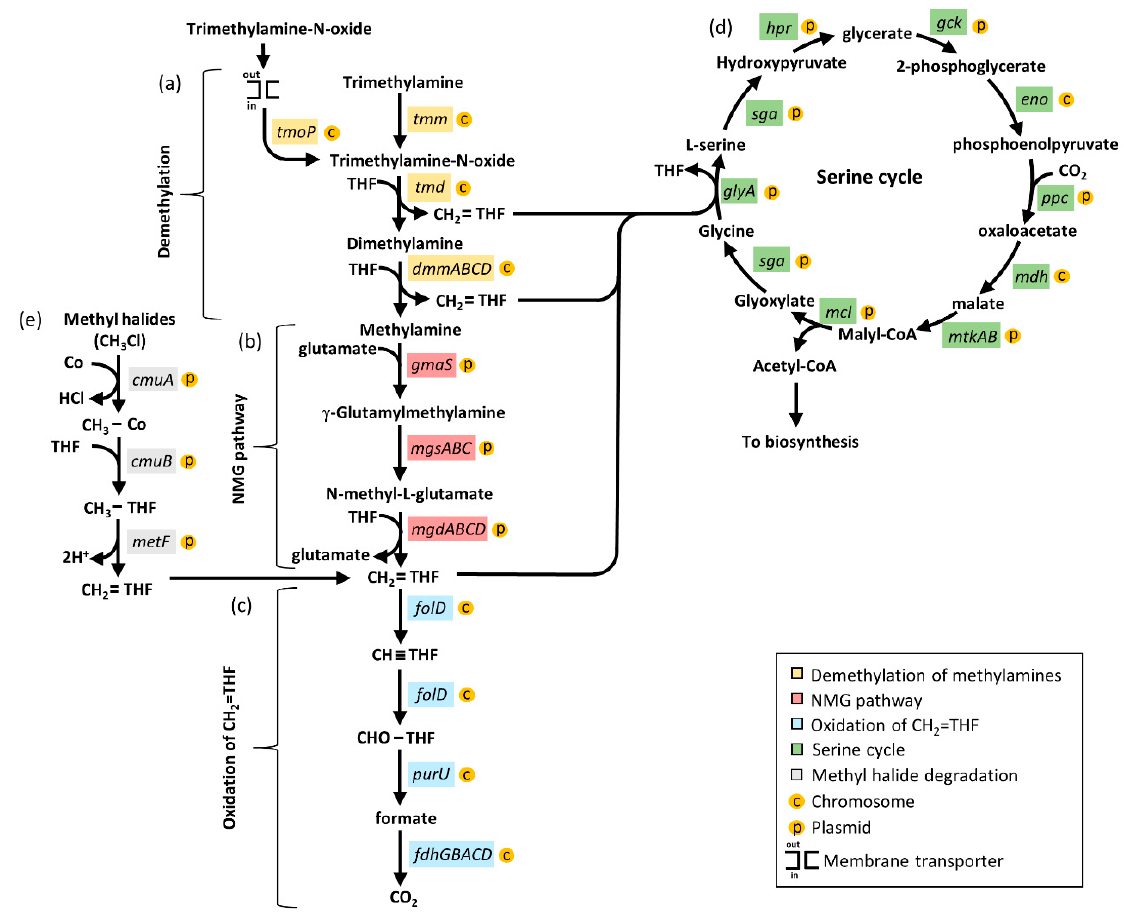
Figure 6. Methylotrophic metabolism in the Aminobacter genus. Genes are colored according to the metabolic pathway (see key). ( a ) Demethylation of methylamines: tmm , trimethylamine monooxygenase; tmd , trimethylamine-N-oxide demethylase; tmoP , trimethylamine-N-oxide permease; dmmDABC , subunits of the putative dimethylamine monooxygenase. ( b ) NMG pathway: gmaS glutamate-methylamine ligase; mgsABC , N-methylglutamate synthase subunits; mgdABCD , N-methylglutamate dehydrogenase subunits. ( c ) CH 2 =THF oxidation: folD , 5,10 methylene tetrahydrofolate dehydrogenase/methenyl tetrahydrofolate cyclohydrolase, purU formyl tetrahydrofolate deformylase; fdhGBACD , NAD-dependent formate dehydrogenase subunits. ( d ) Serine cycle: glyA , serine hydroxymethyltransferase; sga , serine glyoxylate aminotransferase; hpr , hydroxypyruvate reductase, gck , glycerate 2-kinase; eno , enolase; ppc phosphoenolpyruvate carboxylase; mdh , malate dehydrogenase; mtkAB , malate-CoA ligase; mcl , malyl-CoA lyase. The scyR (serine cycle regulator) gene encoding a putative transcriptional regulator is not shown in figure. ( e ) Methyl halide degradation: cmuA , methyltransferase I; cmuB , methyltransferase II; metF , 5,10-methylenetetrahydrofolate reductase. Orange circles indicate the location in the A. aminovorans KCTC 2477 genome (C for chromosome and P for plasmid).